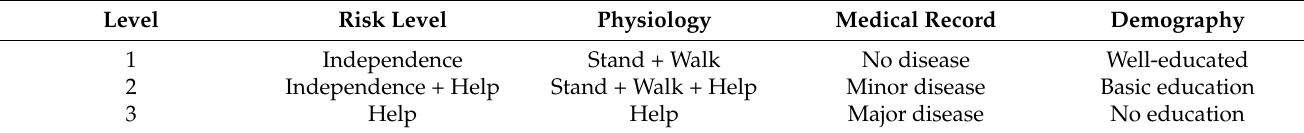
Figure 5. The System Architecture of the Prototype System. Table 1. Levels of Features of LCDA.